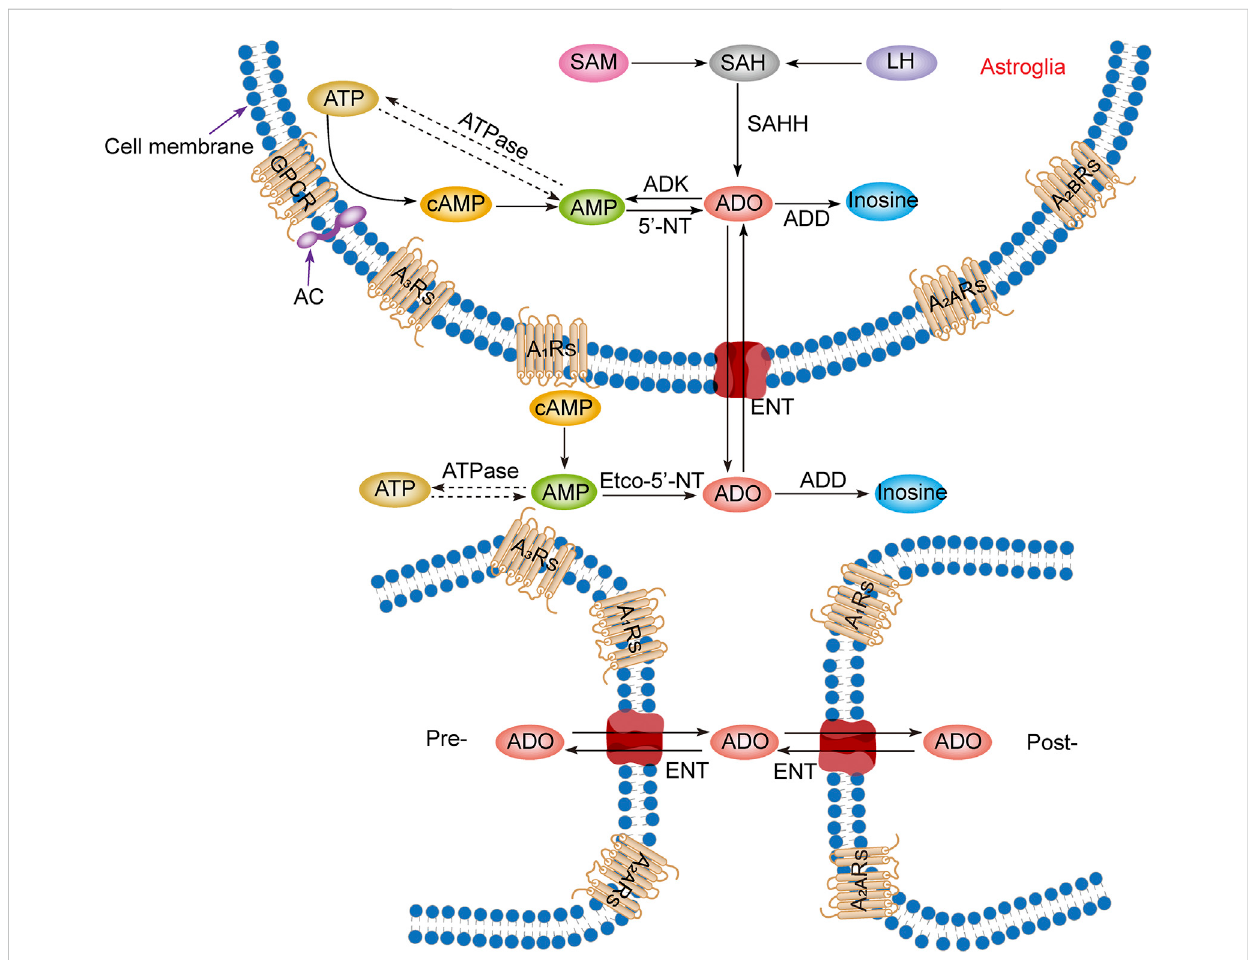
Adenosine metabolism and P1 receptors in the central nervous system. Adenosine metabolism occurs mainly in neuronal synapses and astrocytes. In cells, adenosine is formed from ATP, cAMP, or SAH. Extracellular adenosine is produced by ATP and cAMP metabolism but mainly by the balance of nucleoside transporters to regulate the concentration level inside and outside the membrane. SAM, S-adenosylmethionine; SAH, S-adenosyl homocysteine;LH,L-homocysteine; SAHH,S-adenosyl homocysteinehydrolase;ATP,adenosine triphosphate; ADP,adenosinediphosphate;AMP, adenosine monophosphate; cAMP, cyclic adenosine monophosphate; ADO, adenosine; ADD, adenosine deaminase; ADK, adenosine kinase; 5 ′ -NT, 5 ′ - nucleotidase; etco-5 ′ -NT, etco-5 ′ -nucleotidase; AC, adenylate cyclase; GPCR, G protein-coupled receptors; ENT, equilibrating nucleoside